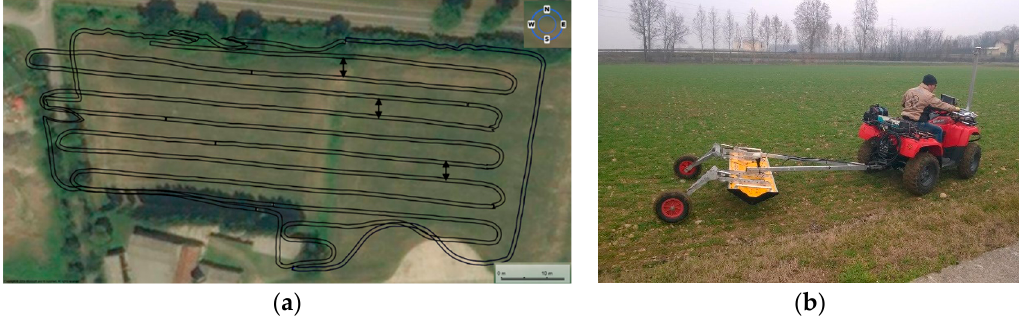
represent the scan offset); ( b ) GPR acquisition system.